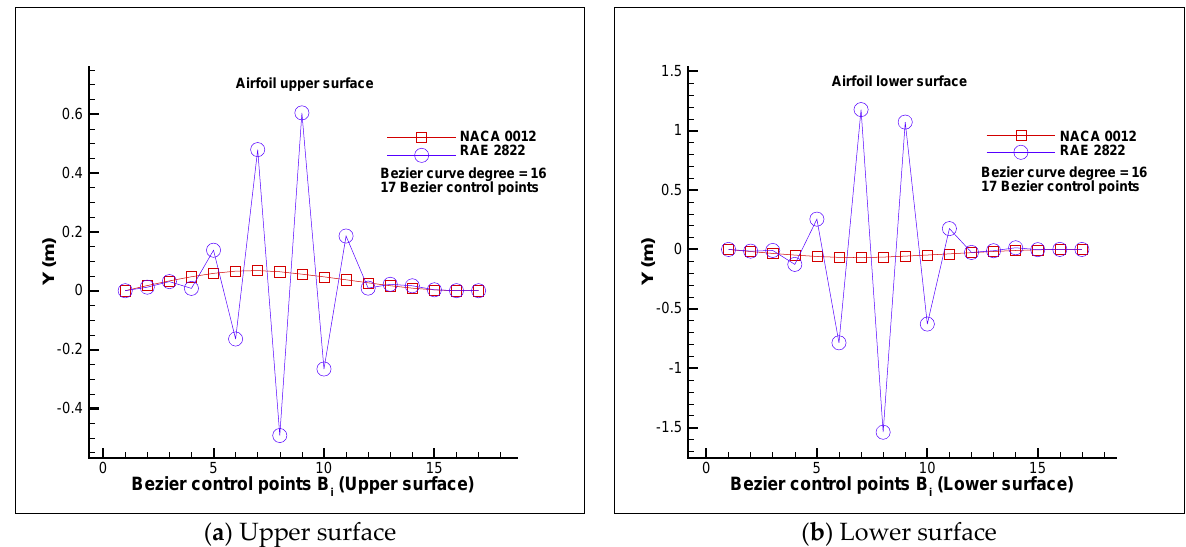
Figure 2. Comparison of the control points of Bezier curve of degree 16 for reconstructing the NACA 0012 and RAE 2822 airfoils.